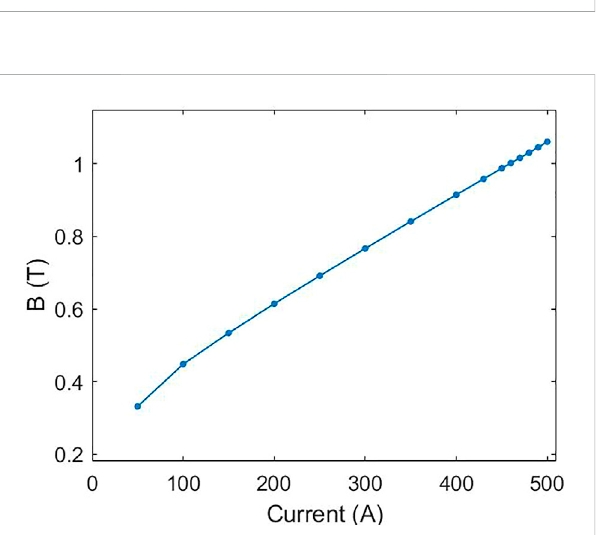
FIGURE 5 The structure model (A) and the photo (B) of the SCU short mock-up.